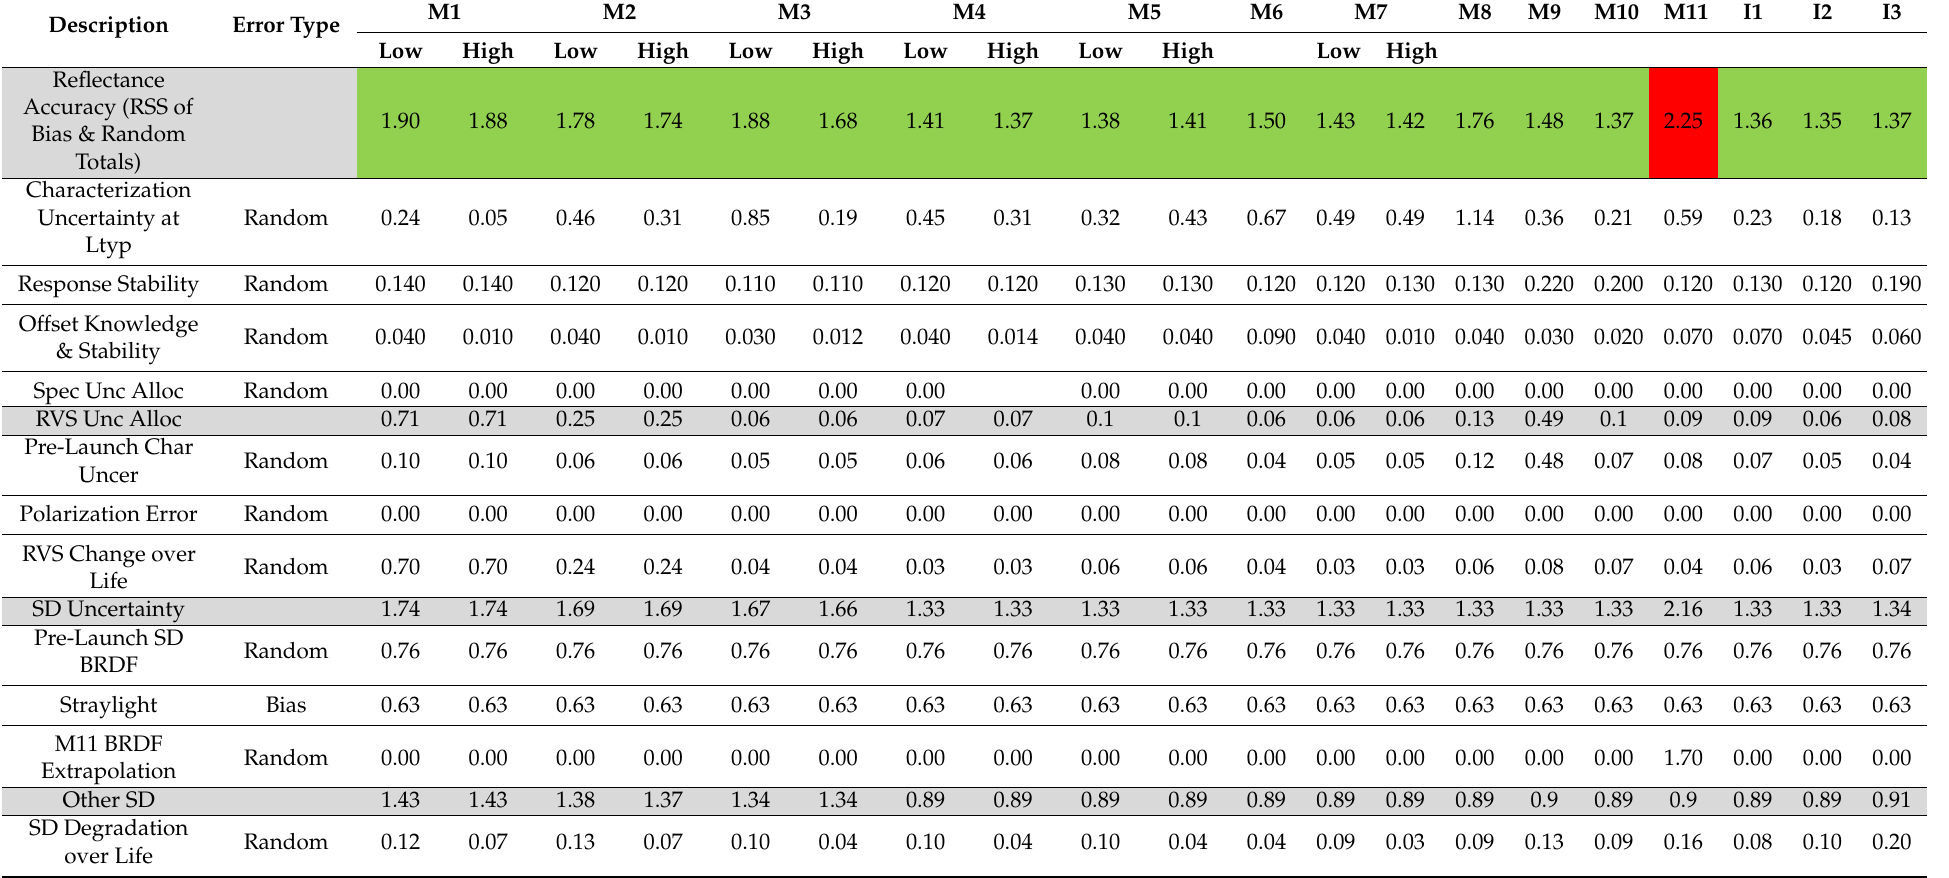
Table 6. A breakout of the reflective solar band calibration uncertainty tree for each component and a total rollup (highlighted in green for pass and red for fail). Band M11 fails due to high uncertainty in the SD BRF